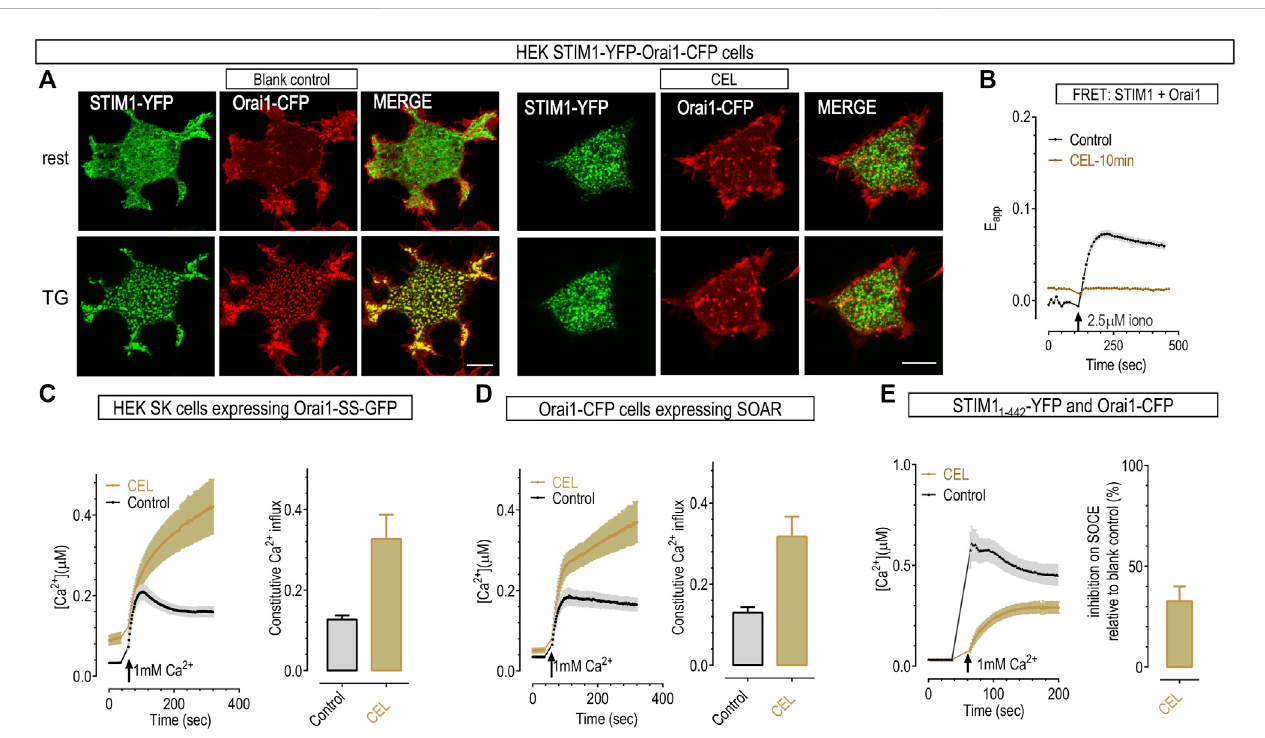
FIGURE 4 50 μ M celastrol disrupted functional couplings between Orai1 and STIM1 but had no effect on Ca2+ in fl uxes mediated by Orai1 and SOAR. (A) Typical confocal images showing the effect of 10-min celastrol on the colocalization between STIM1-YFP (green) and Orai1-CFP (red) in HEK STIM1-Orai1 cells. Top panels, store replete cells. Unlike control cells that show even distribution, 10 min-incubation with celastrol induced the formation of small STIM1 puncta at rest (upper images). Bottom panels, store-depleted cells after 10-min bath with 1 μ M TG. STIM1 in control cells aggregated into large puncta, while STIM1showedno-furtheraggregationincelastrol-treatedcells.Scalebar,10 μ m. (B) Celastrol ’ seffectsonFRETsignalsbetweenSTIM1-YFPandOrai1-CFPin HEK STIM1-Orai1 cells. Compared to control, pretreatment with celastrol resulted in a rise in basal FRET signal, and a decrease of the FRET signal after store depletion. Store-emptying ionomycin failed to induce any further increase in celastrol-treated cells. (C,D) Celastrol did not inhibit the constitutive Ca 2+ entry mediated in HEK SK cells transiently expressing Orai1-SS, or co-expressing Orai1 and SOAR. Left, Typical traces; right, Statistics. (E) Pre-incubation with celastrol inhibited SOCE in cells co-expressing Orai1 and STIM1 1-442 . Prior to recordings, ER Ca 2+ stores were emptied by bathing cells in Ca 2+ free solution containing 1 μ M TG for 10 min. Left, Typical traces; right,